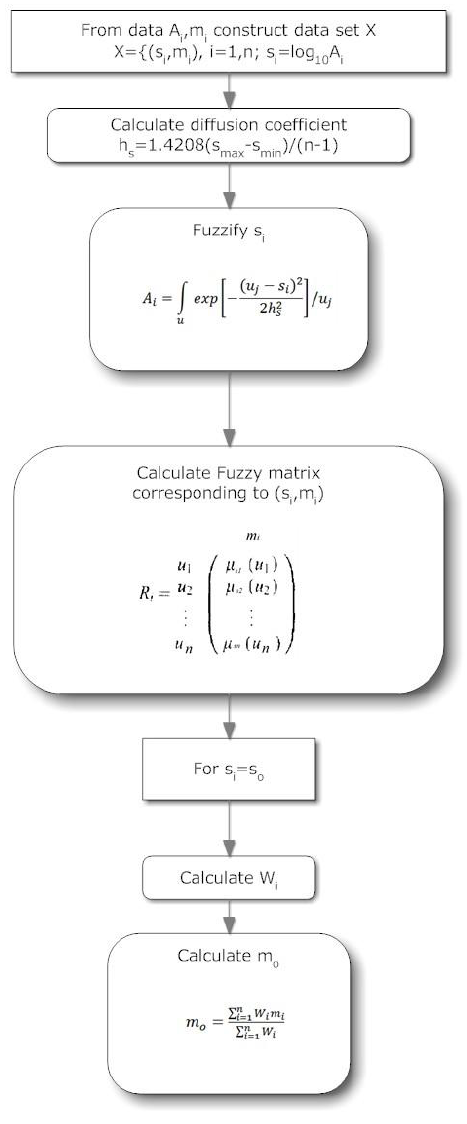
Fig. 6. Flowchart depicting the information diffusion method.